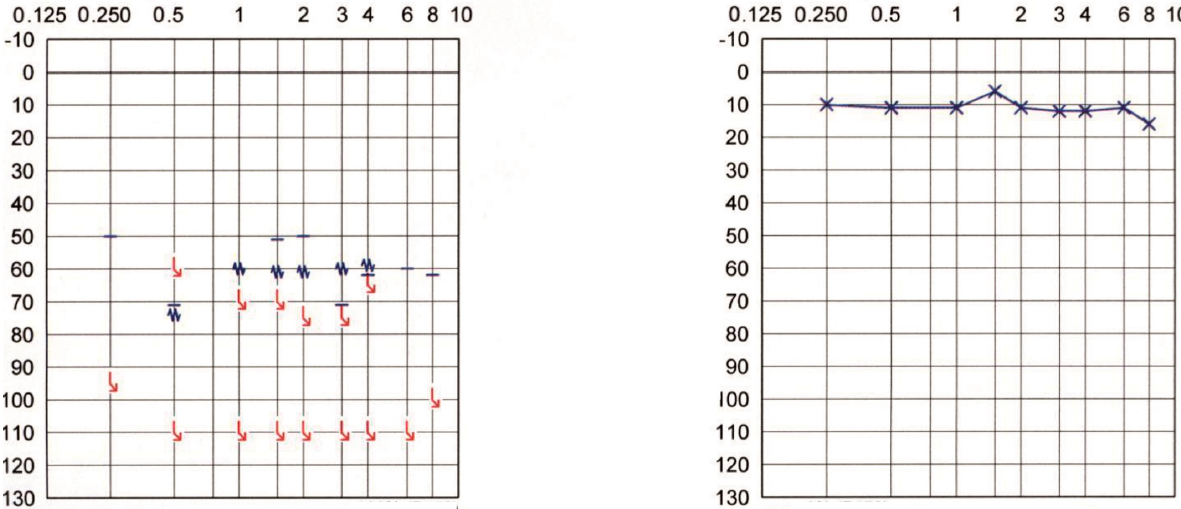
Figure 3. Pure tone audiogram of Patient #4 approximately 17 years after translabyrinthine surgery for right-sided vestibular